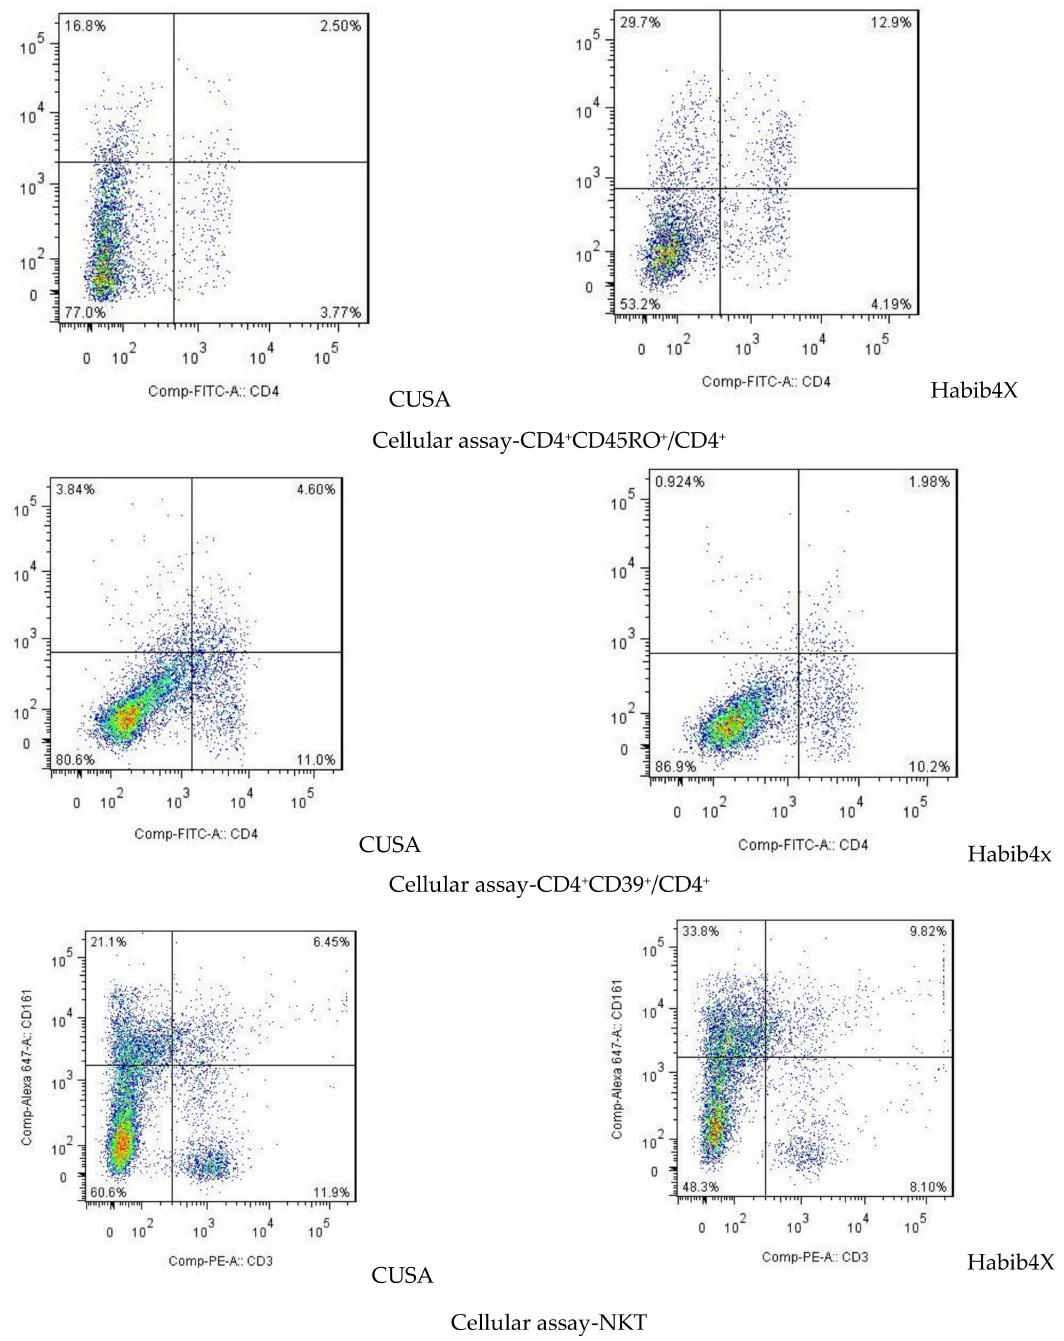
Figure 1. Flow cytometric analysis of immune cells in peripheral blood 7 days after liver resection with CUSA or Habib TM